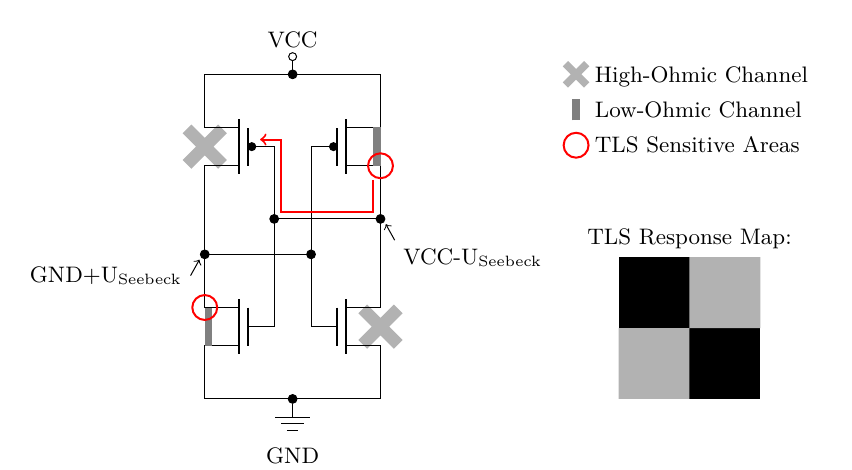
Figure 3: SRAM cell under thermal stimulation and expected simplified TLS response